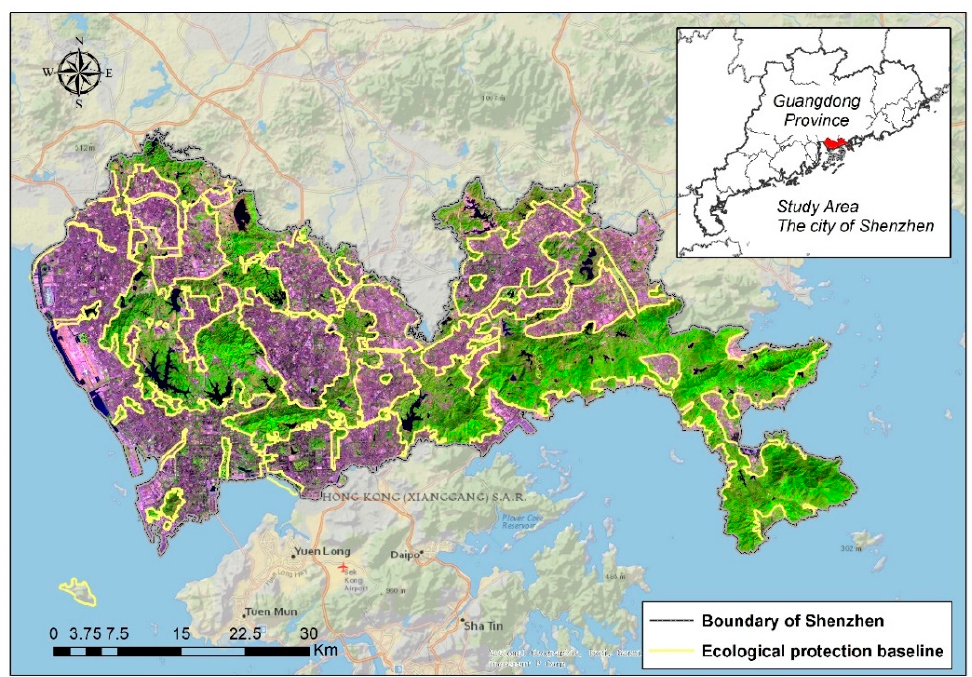
Figure 1. The geographic location of Shenzhen and the Landsat imagery in 2020 (R: SWIR 1 band, G: NIR band, B: Red band). The yellow line represents the ecological protection baseline released in year 2005.